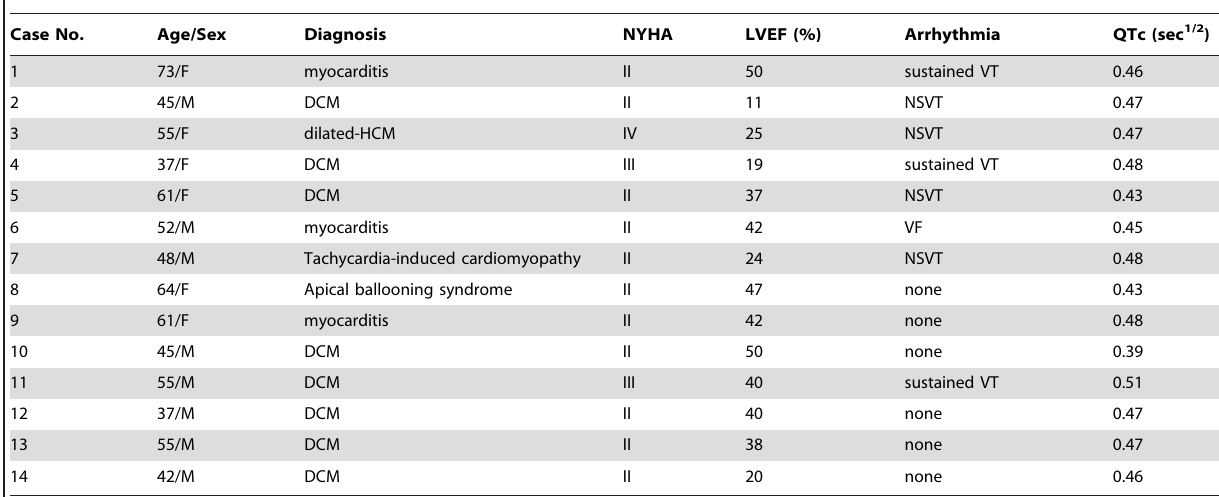
Table 1. Clinical characteristics of the study population.